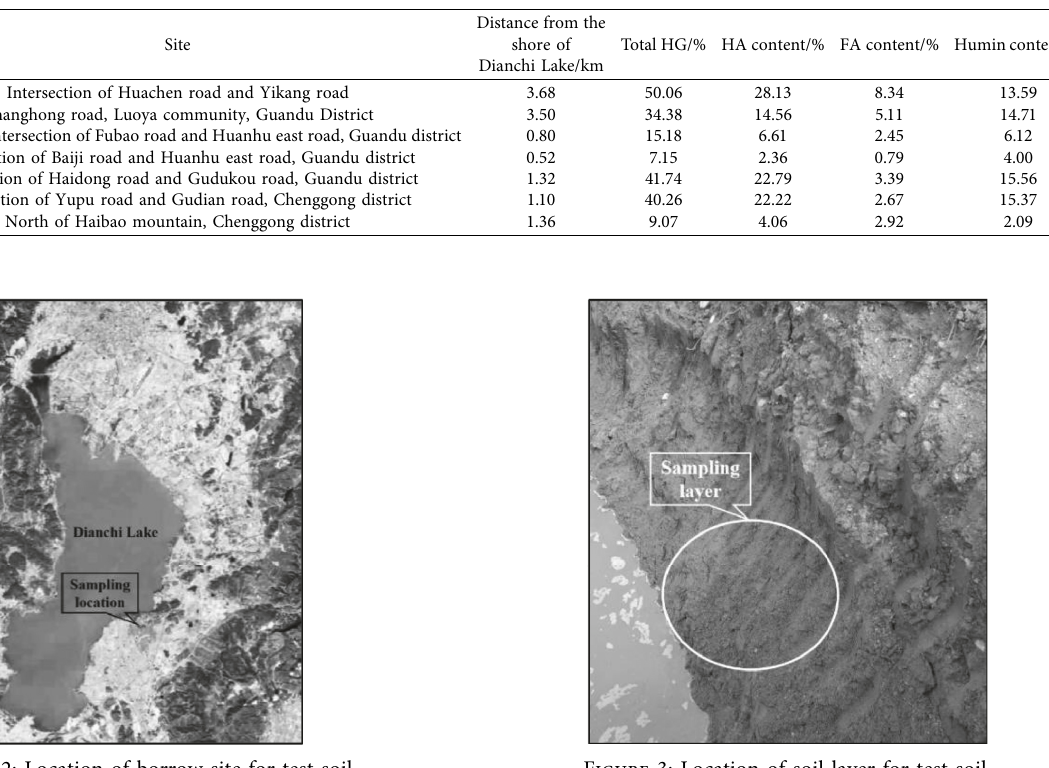
Figure 1: Distribution of sampling sites in Dianchi Lake. Table 1: Determination results of HG content in natural peat soil samples.